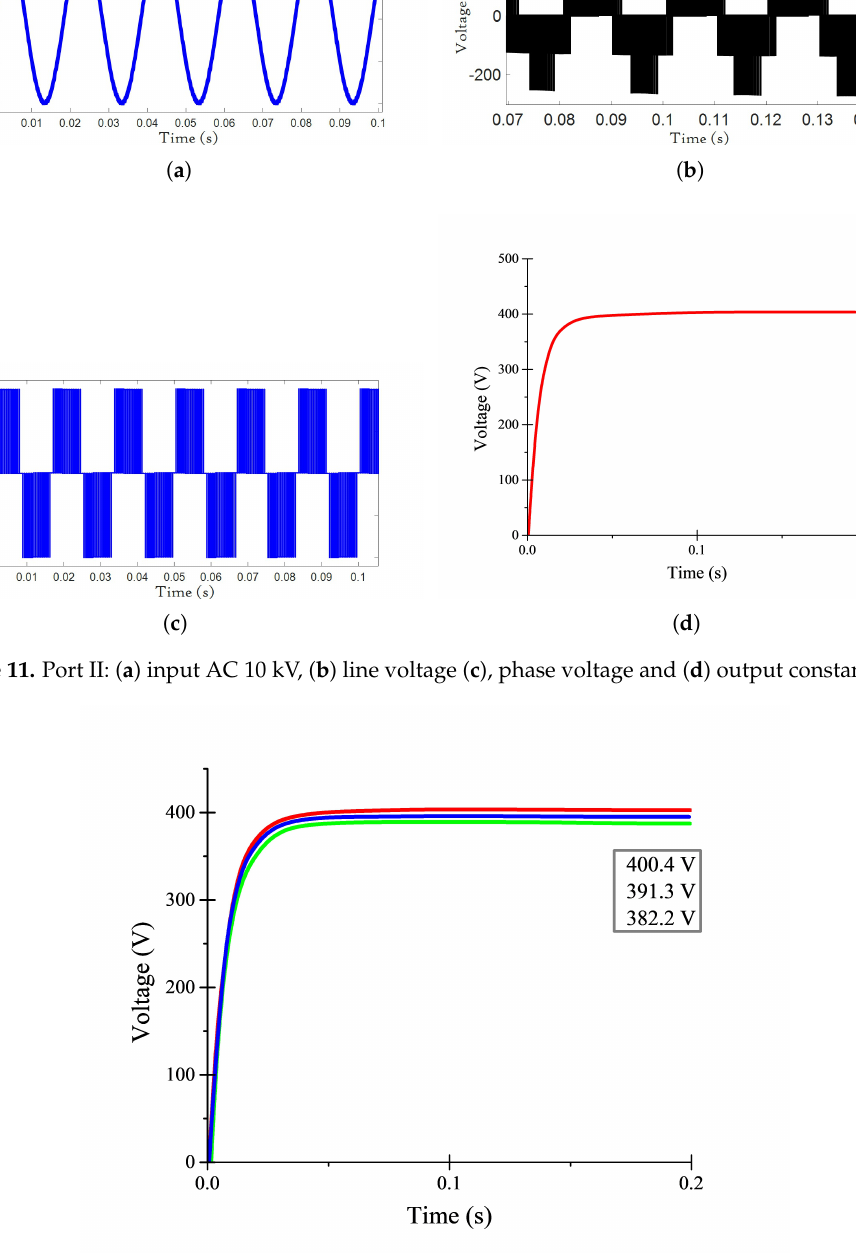
Figure 12. Effects of load